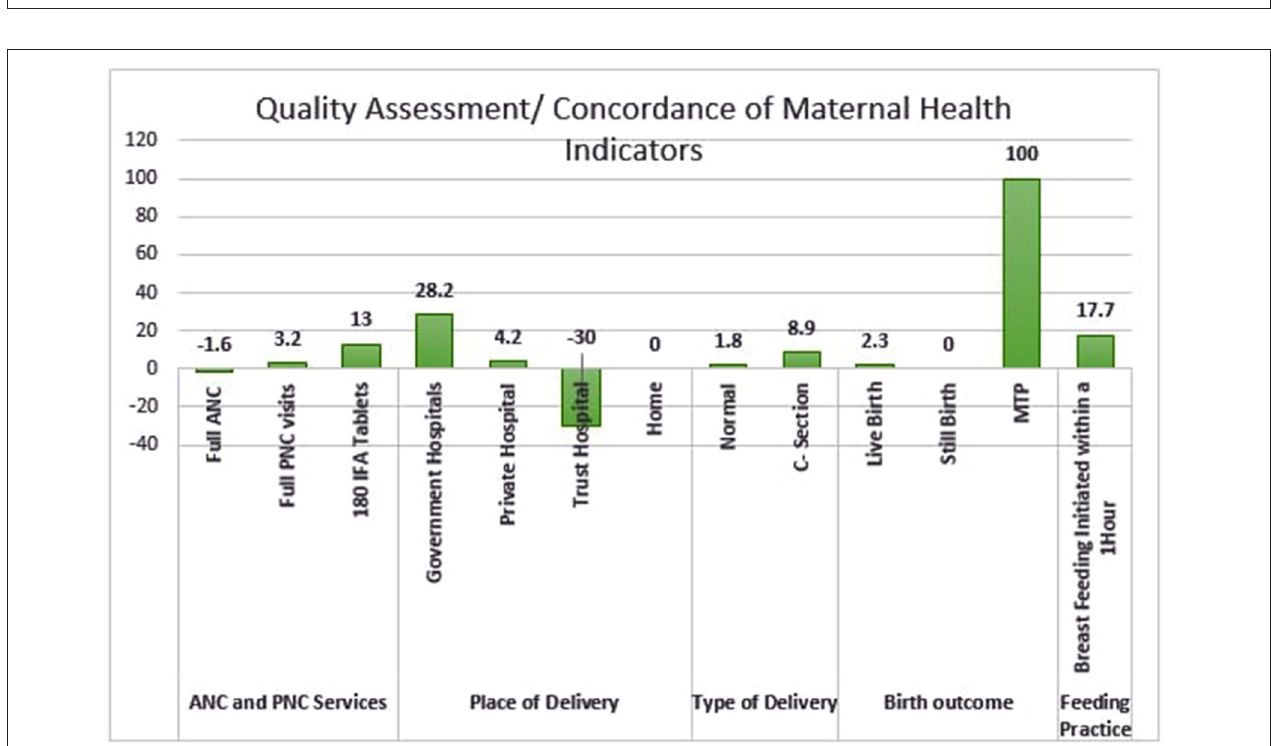
FIGURE 2 | Quality assessment of maternal health